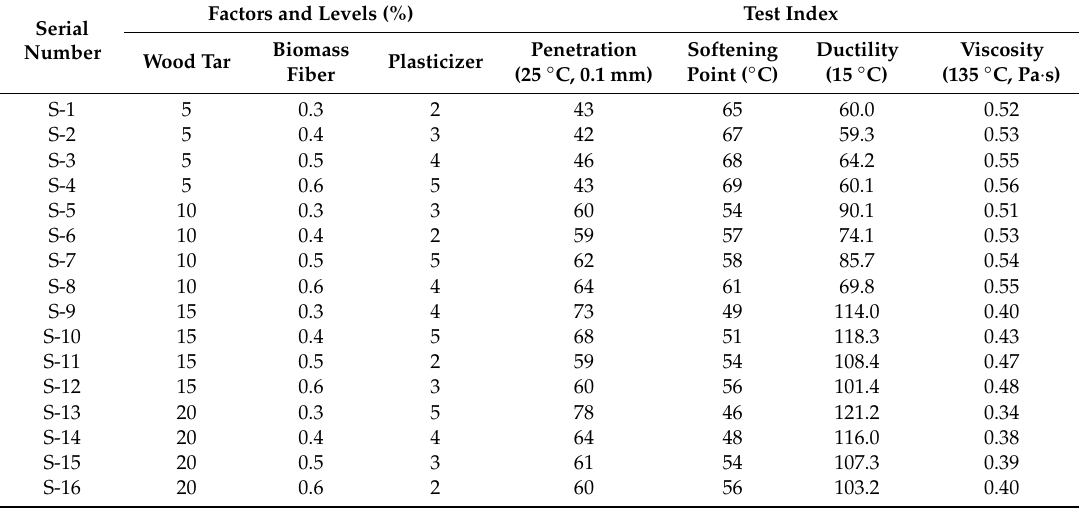
Table 5. Composition of wood tar-based rejuvenator and performance test results of its rejuvenated